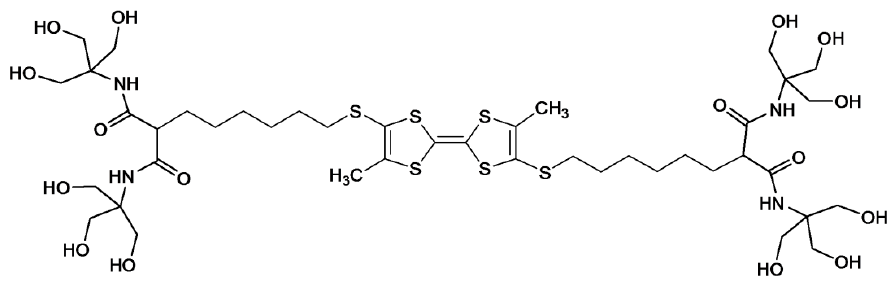
Figure 2. Molecular structure of gel-forming bolaamphiphile with a tetrathiafulvalene spacer. Adapted with permission from [11], Copyright © 1994 American Chemical Society.